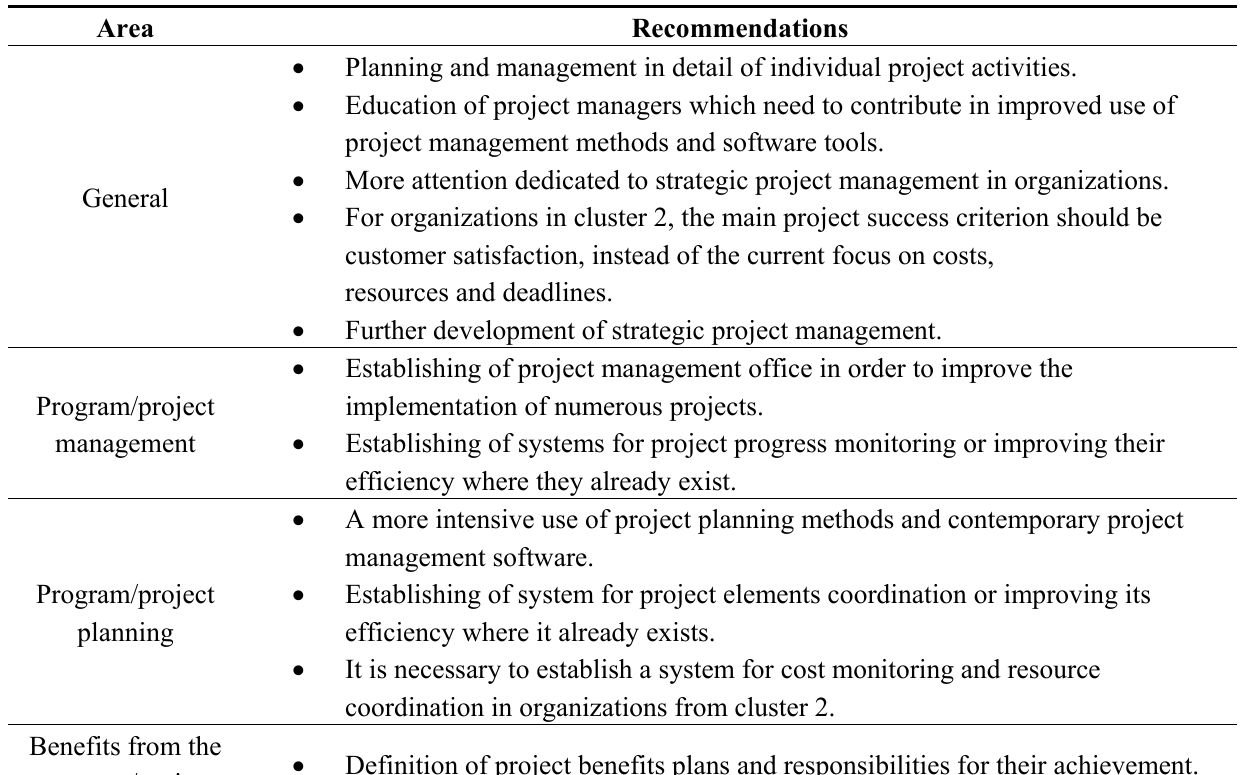
Table 5. The most important recommendations for improving the level of project management maturity in Serbian energy sector